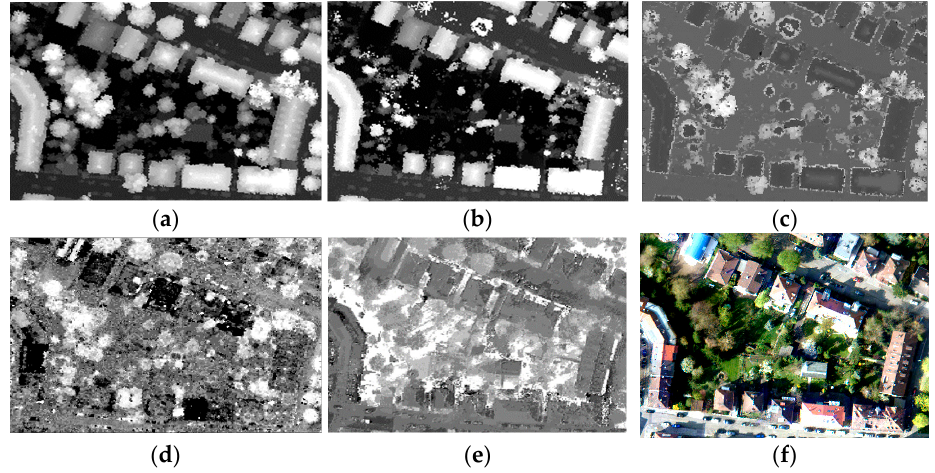
Figure 9. Test set 2 used in classification process: ( a ) FE; ( b ) LE; ( c ) HD; ( d ) IN; ( e ) NDVI; ( f ) RGB. In order to evaluate the feature classification method proposed, the experimental re- sults were compared—F-DS-FH [51] and DS. DS is the basic DS evidence theory approach, and F-DS-FH is the DS evidence theory approach based on a hierarchical framework with fuzzy BPA function and median filtering. The performance of the proposed feature classifi- cation method was evaluated using a confusion matrix to make an objective assessment. In addition, the Kappa coefficient was calculated for measuring the classification accuracy. Assuming that the true number in each category is 𝑎 (cid:2869) , 𝑎 (cid:2870) , ⋯ 𝑎 (cid:3030) , and the number of samples in each category in the classification result is 𝑏 (cid:2869) , 𝑏 (cid:2870) , ⋯ 𝑏 (cid:3030) , respectively, and the total number of samples is 𝑛 , we have 1